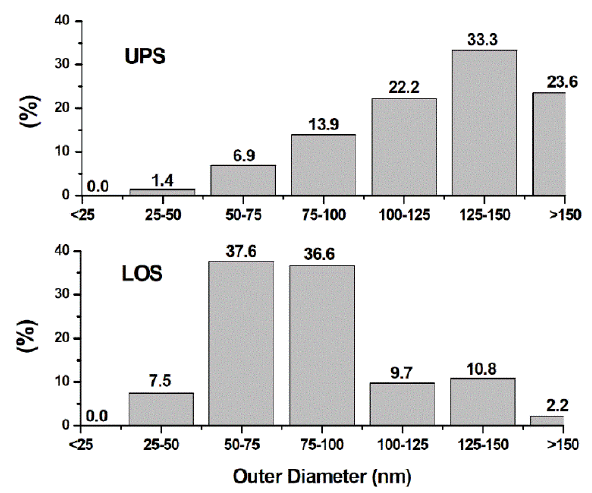
Figure 8. The distributions of the outer diameters of halloysite from TEM for the UPS and LOS samples. Unit is nanometer (nm).